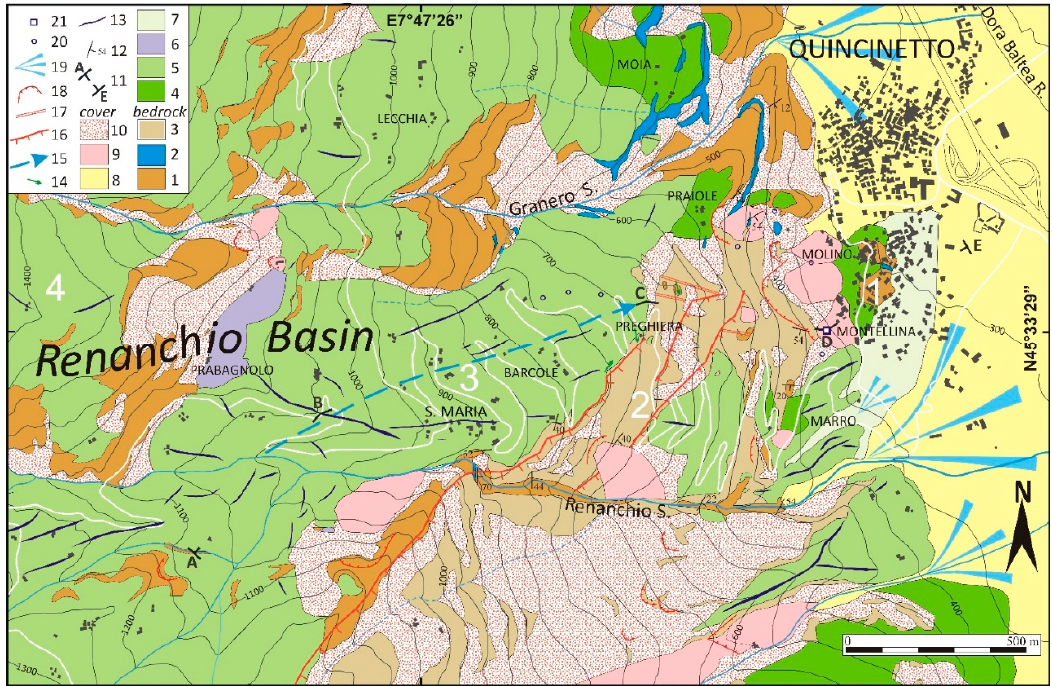
Figure 4. Geological map of the Dora Baltea Valley slope comprising the Montellina Spring. (1)